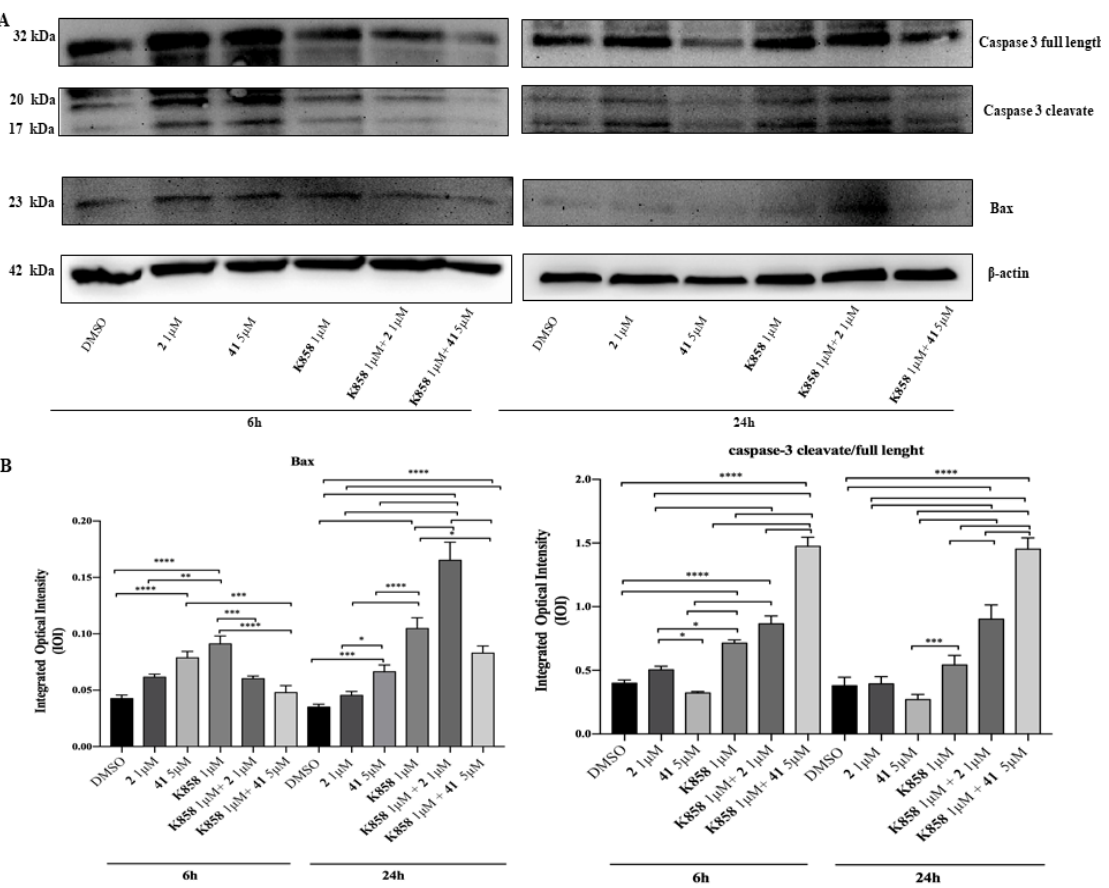
Figure 6. Western blotting analysis of Bax and Caspase-3 expression in AGS cell line treated with compounds 2, 41, K858 as single agents and in co-treatment . ( A ) Cells treated with DMSO (0.2%) were loaded as negative control. Each membrane was probed with β -actin antibody to verify loading consistency. Western blot is the most representative of three di ff erent experiments. ( B ) Histograms represent densitometric measurements of proteins bands expressed as integrated optical intensity (IOI) mean of three separate experiments. The error bars show standard deviation ( ± SD). Densitometric values analyzed by ANOVA (post hoc application of Tukey’s multiple comparison test) return significant di ff erences. **** p < 0.0001, *** p < 0.0002, ** p < 0.0005, * p < 0.005.